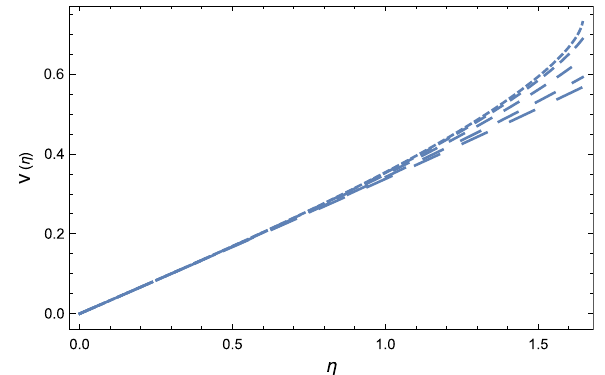
Fig. 3 Variation of the dimensionless velocity profile V (η) as a func- tionofthedimensionalradialcoordinate η ofacollapsingrotatingBose– Einstein condensate dark matter halo for different values of the parame- ter γ 0 duringitsdynamicalevolutionfor γ 0 = 0(solidcurve), γ 0 = 0 . 25 (dotted curve), γ 0 = 0 . 50 (short dashed curve), γ 0 = 0 . 75 (dashed curve),and γ 0 = 0 . 90(longdashedcurve),respectively.Tonumerically integrate the system of equations (136) and (137) we have used the ini- (η ) = ( 12 /π)η 2 tialconditions m 0 (η 0 ) = ( 4 /π)η 3 and u (η 0 ) = m (cid:12) , 0 0 0 0 with η 0 = 10 −